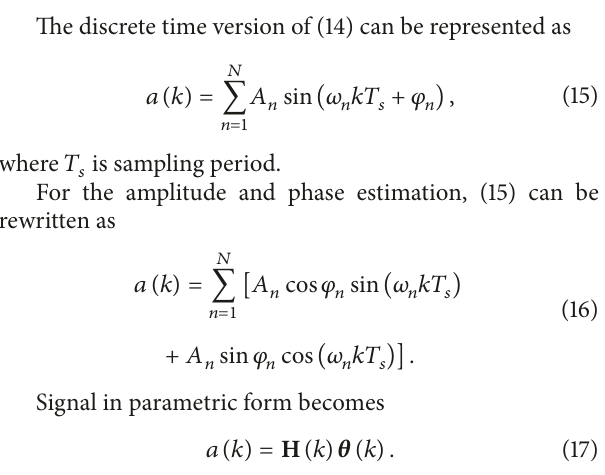
Figure 9: The frequency spectrum of response.